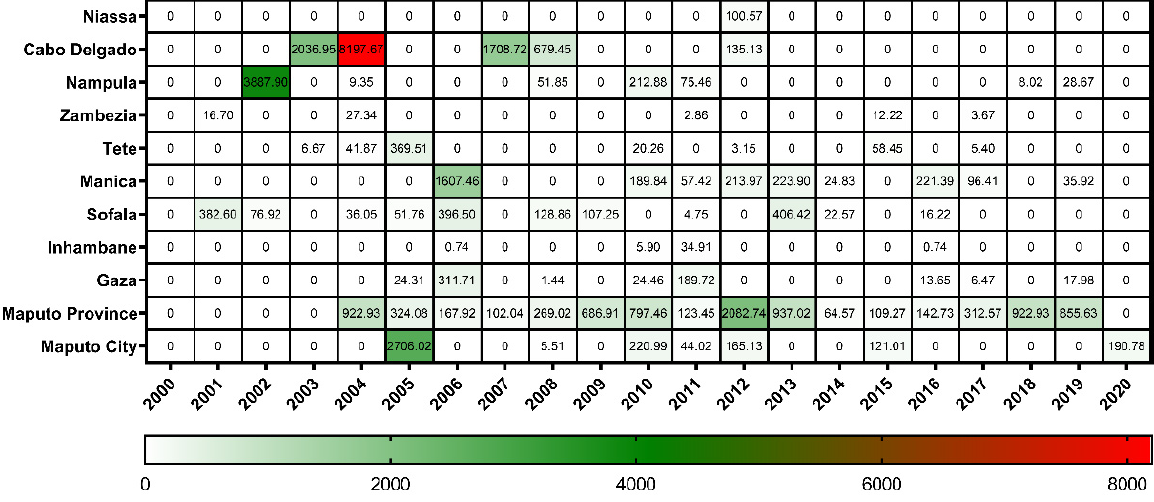
Figure 5. Spatiotemporal distribution of African swine fever in Mozambique between 2000 and 2020. Red represents clusters formed: primary ( A ) and secondary clusters ( B , C ).